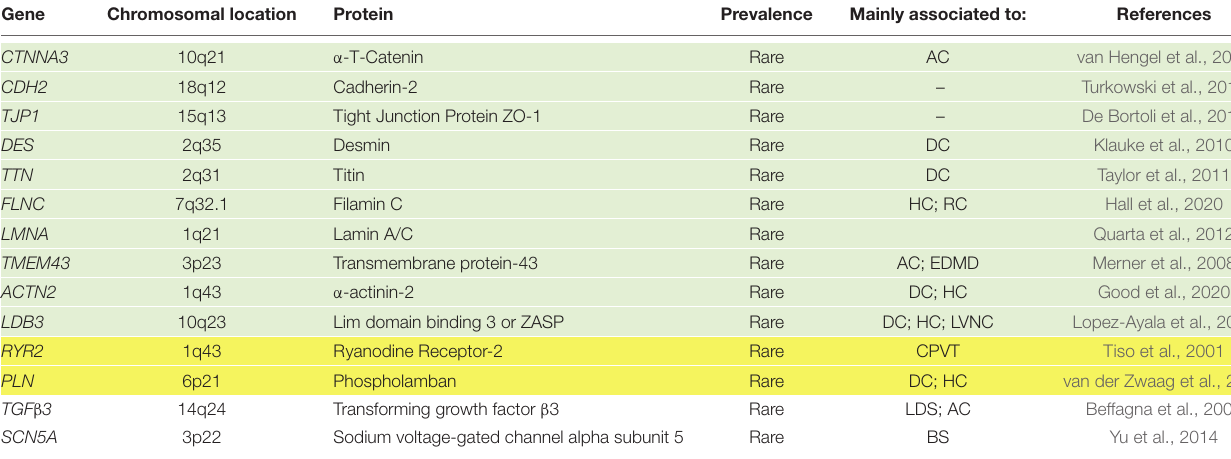
Green, genes with mechanical function; yellow, genes with a function in response to adrenergic stimuli. Association based on Online Mendelian Inheritance in Man catalog. AA, Aortic Aneurism; AC, Arrhythmogenic Cardiomyopathy; BS, Brugada Syndrome; CPVT, Catecholaminergic Polymorphic Ventricular Tachycardia; LDS,